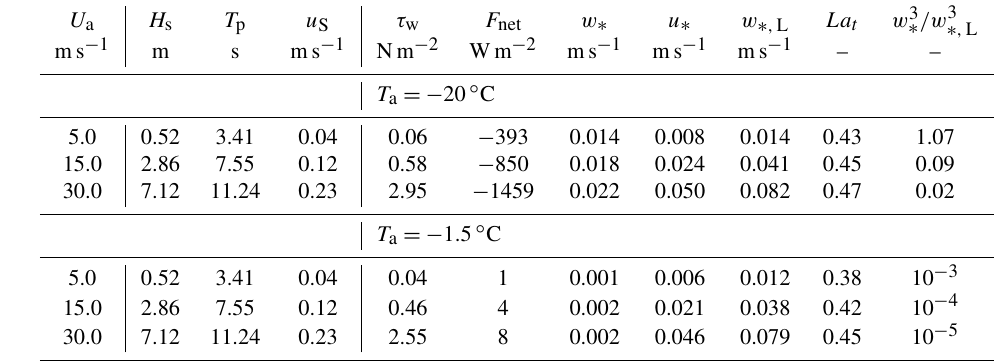
Table 2. Model forcing computed for different combinations of U a and T a with formulae described in Sect. S1. U a H s T p u S τ w